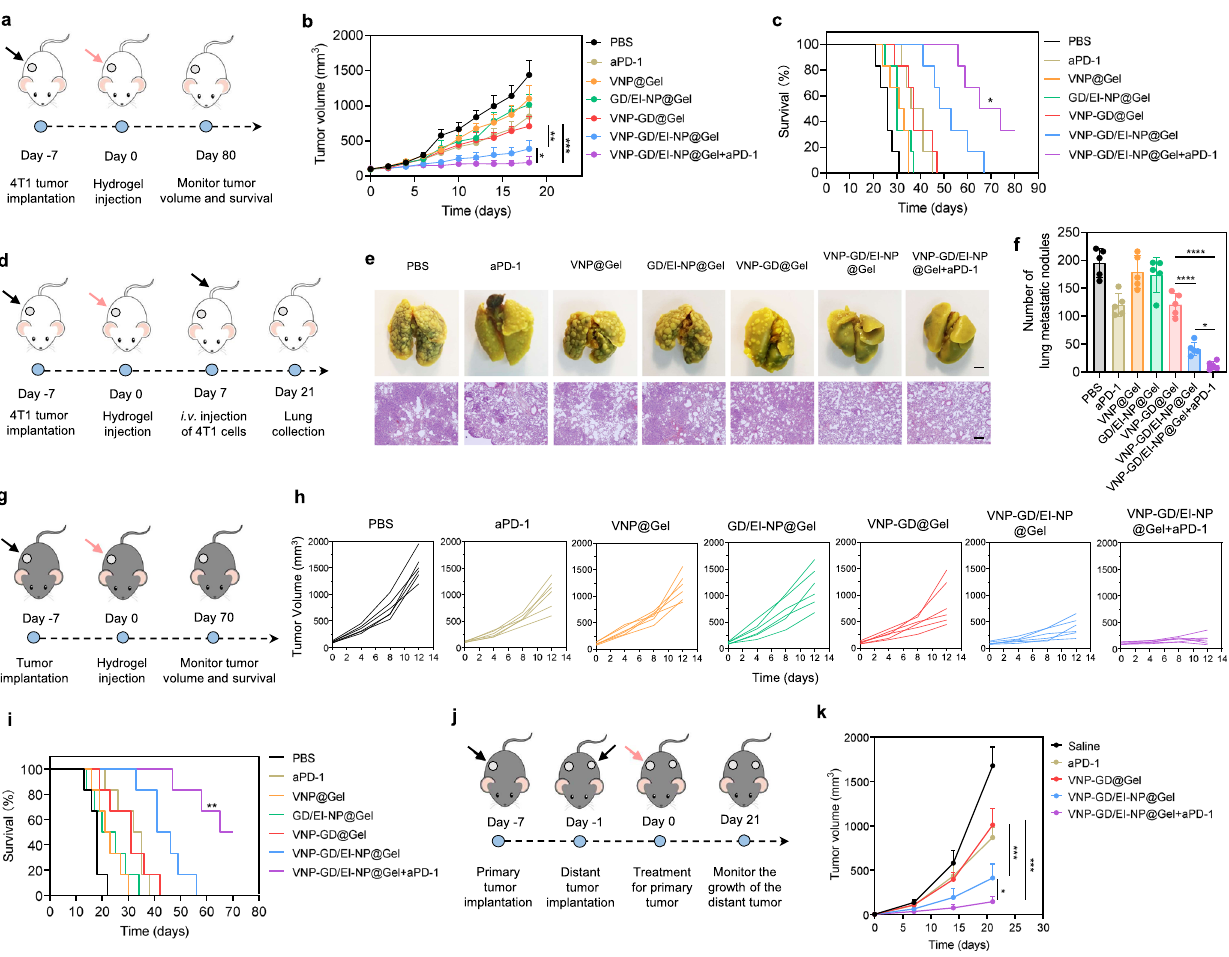
Fig. 4 | Antitumor ef fi cacy in 4T1 metastatic triple-negative breast cancer models and B16F10 melanoma models. a Schematic illustration of the estab- lishment and treatment strategy in 4T1 breast tumor model. b 4T1 tumor growth curvesafterdifferenttreatments.Dataarepresentedasmean±s.d.( n =6mice)and analyzed with two-way ANOVA followed by Tukey ’ s multiple comparisons test. VNP-GD/EI-NP@Gel+aPD-1vs.VNP-GD/EI-NP@Gel:* P =0.0259;VNP-GD/EI-NP@Gel vs. VNP-GD@Gel: ** P =0.0046; VNP-GD@Gel vs. VNP-GD/EI-NP@Gel+aPD-1: *** P =0.0001. c Survival curve of the 4T1 tumor-bearing mice after different treat- ments ( n =6 mice). Data are analyzed with Log-rank (Mantel-Cox) test. VNP-GD/EI- NP@Gel vs. VNP-GD@Gel: ** P =0.0085; VNP-GD/EI-NP@Gel+aPD-1 vs. VNP- GD@Gel: *** P =0.0005; VNP-GD/EI-NP@Gel+aPD-1 vs. VNP-GD/EI-NP@Gel: * P =0.0308. d Schematicillustrationoftheestablishmentandtreatmentstrategyof the breast tumor lung metastasis model. e Representative lung images and H&E assayafterdifferenttreatments( n =5mice,scalebar=2mmforlungtissueimages and200 µ mforH&Estainingimages). f